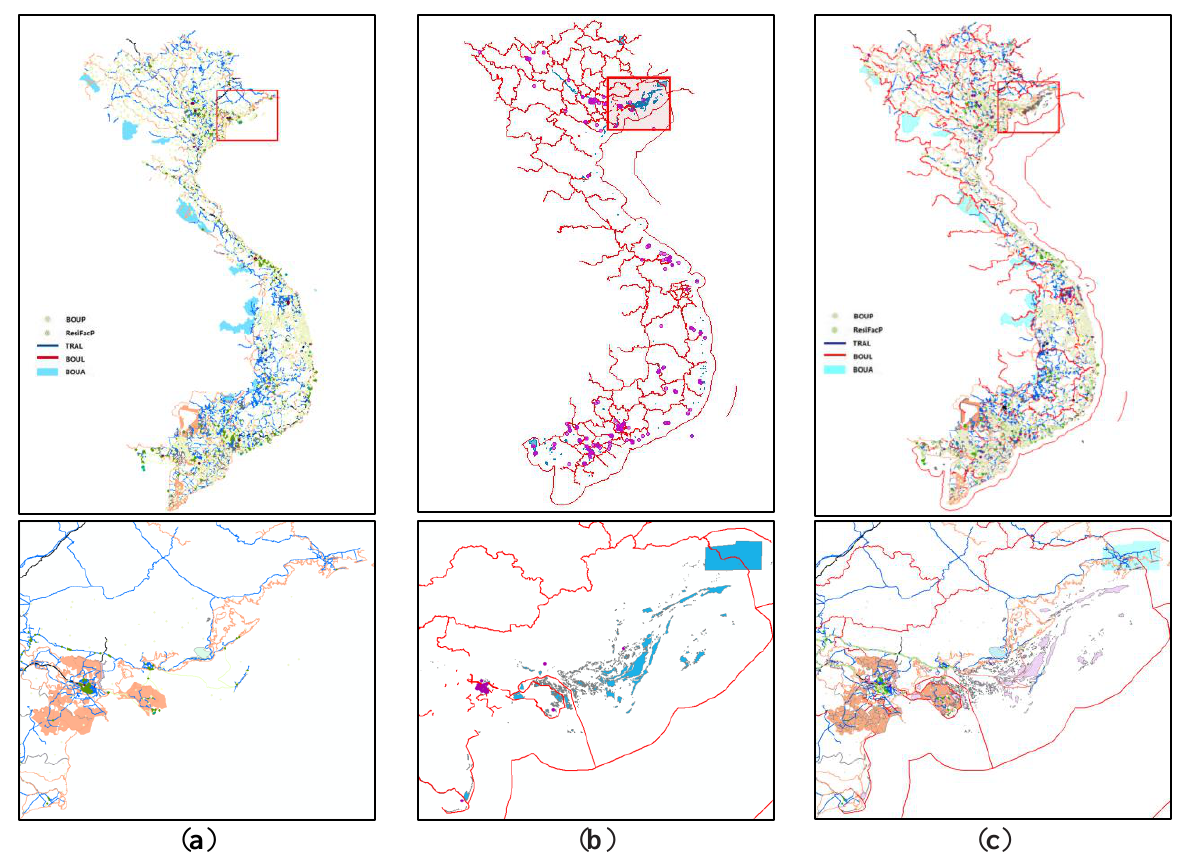
Figure 6. Model transformation experiment data (Vietnam, 8 October 2013). ( a ) The data transferred by the 1180 basic rules; ( b ) the objects cannot be transferred using the basic rules; ( c ) the complete data can be transferred using universal